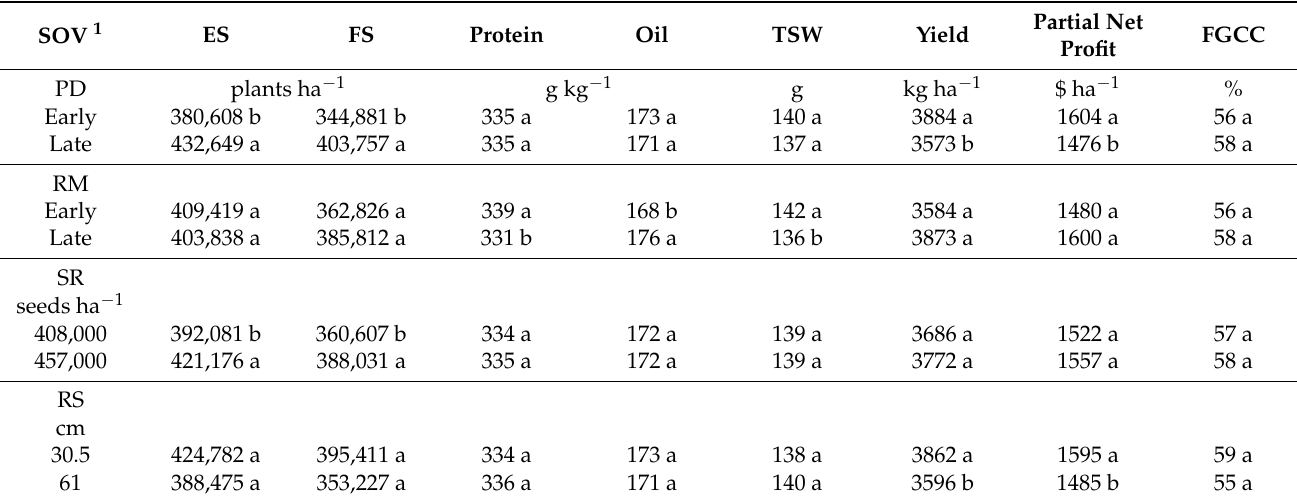
Within columns, for each main factor, means followed by the same letter are not significantly different at p ≤ 0.05. 1 SOV, source of variation; ES, established stand; FS, final stand; TSW, 1000 seed